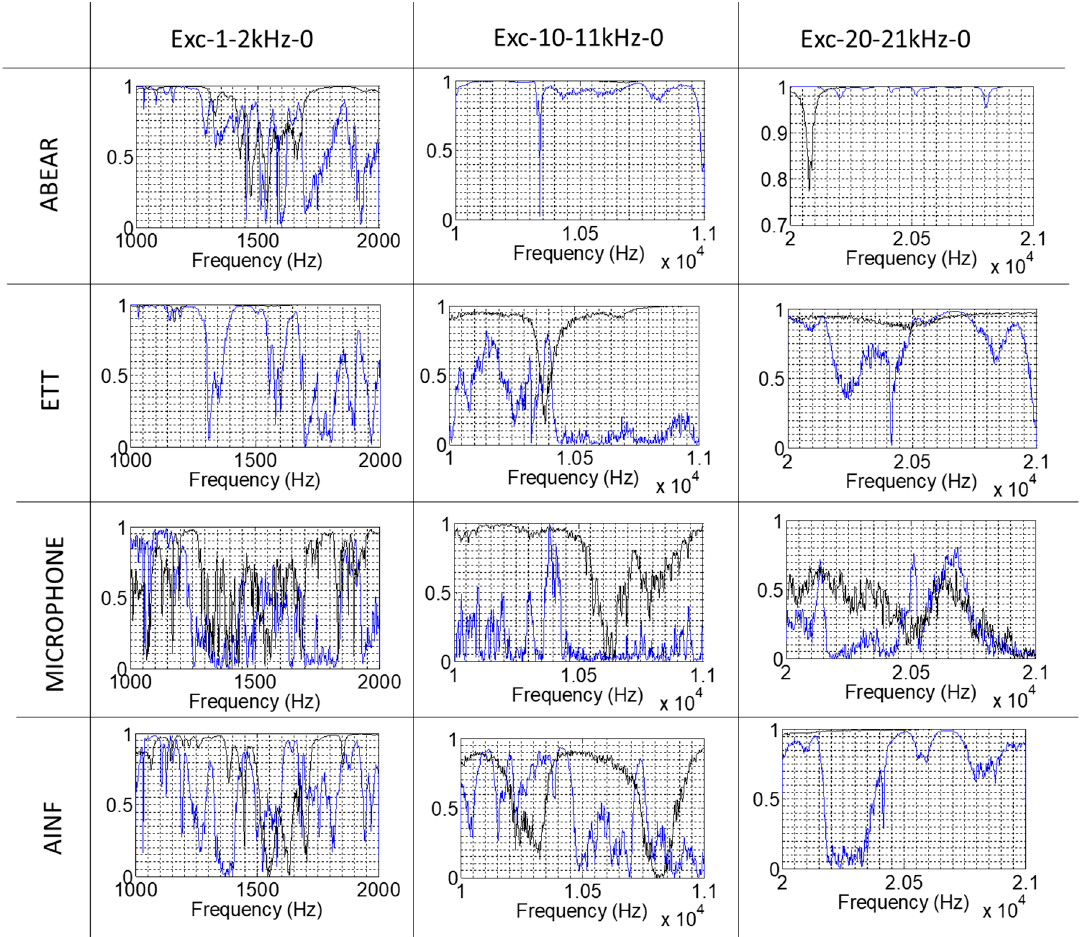
Figure 5. Coherence between the sensors of the stationary frame with respect to the PZT. The blue line is the “in air” configuration, and the black line is the “in water” configuration. Non-rotating case.